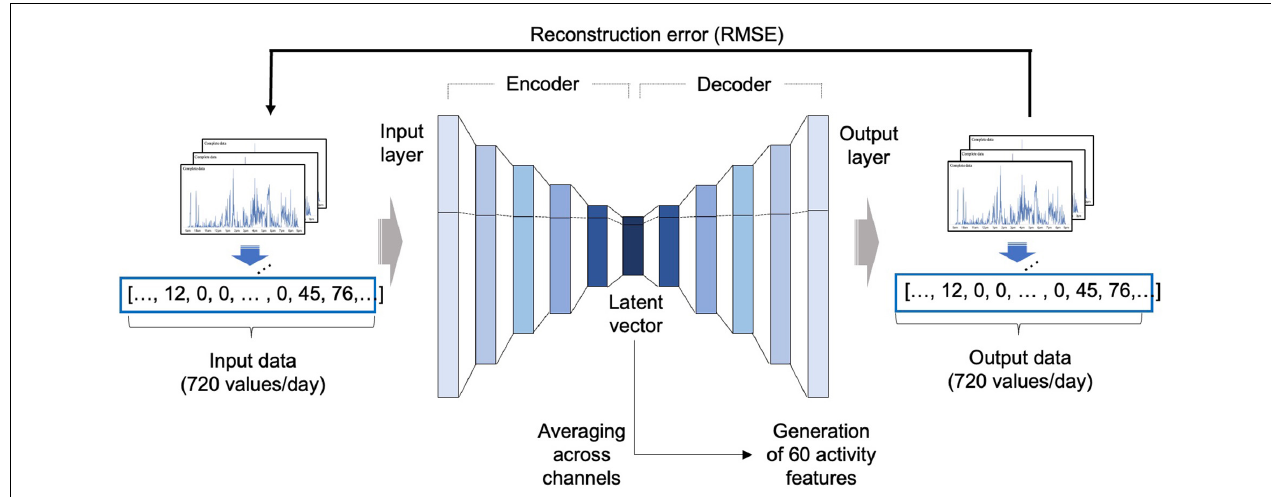
FIGURE 2 | Development of the autoencoder model. An autoencoder consists of an encoder that receives input data and compresses the information into a latent feature, and a decoder that receives the compressed latent feature and restores the original input in the direction that minimizes the RMSE. In this study, after autoencoder training using the NHANES data, a latent vector was obtained from the activity dataset of the BICWALZS by applying the encoder portion of the autoencoder and averaging across channels to obtain 60 activity features. RMSE, root mean squared error; NHANES, National Health and Nutrition Examination Survey; BICWALZS, Biobank Innovations for chronic Cerebrovascular disease With ALZheimer’s disease